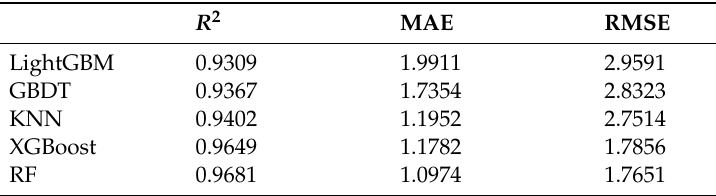
Table 6. Evaluation indexes of the four models.